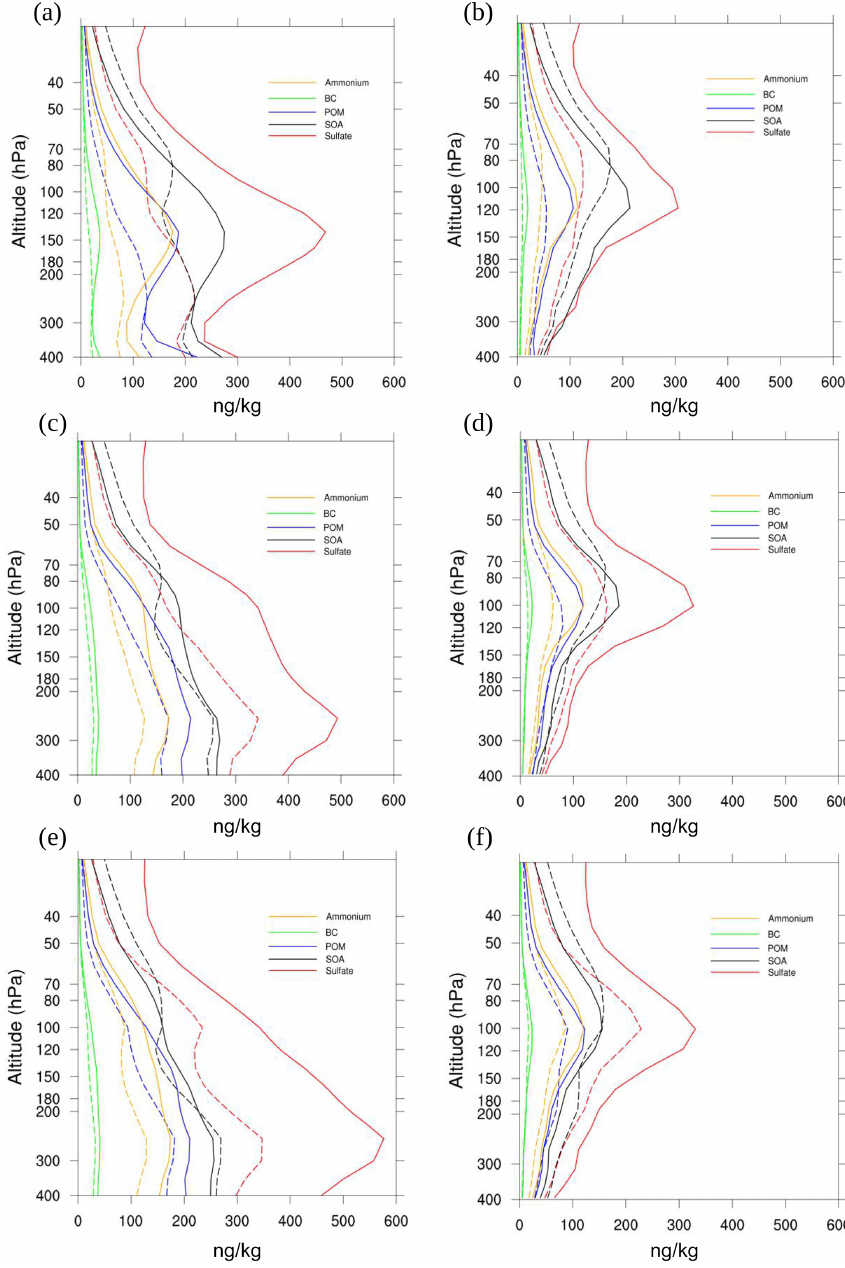
Figure 3. Modeling vertical profiles of aerosol mass concentration of sulfate, SOA, POM, ammonium and BC in the accumulation mode (a1) in ng/kg averaged between 20–35 ◦ N and 60–100 ◦ E; the dashed lines correspond to the year 2000, solid lines the year 2014. (a) Profile for June, (c) July and (e) August. (b) , (d) , (f) : same as (a) , (c) and (e) but with the extinction filter applied ( > 1 . 0 × 10 − 3 km − 1 ) to reduce the contribution of convective cloud-borne